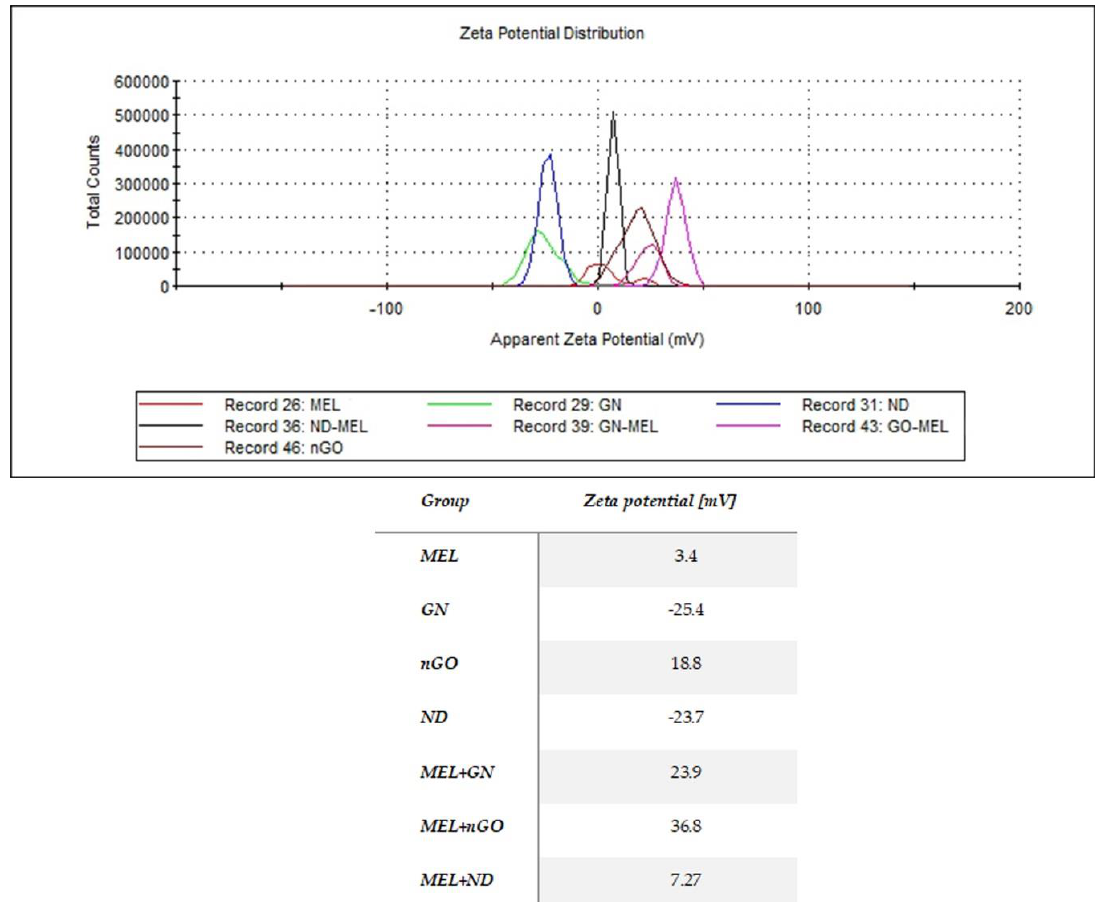
Figure 3. Zeta potential of melittin, nanoparticles and their complexes. MEL—group treated with melittin at a concentration of 10 mg/L; GN—group treated with natural graphene (20 mg/L); Ngo— group treated with graphene nanoxide (20 mg/L); ND—group treated with nanodiamond (20 mg/L); GN + MEL—group treated with melittin complex (10 mg/L) and natural graphene (20 mg/L); nGO + MEL—group treated with melittin complex (10 mg/L) and graphene nanoxide (20 mg/L); ND + MEL—group treated with melittin complex (10 mg/L) and nanodiamond (20 mg/L).